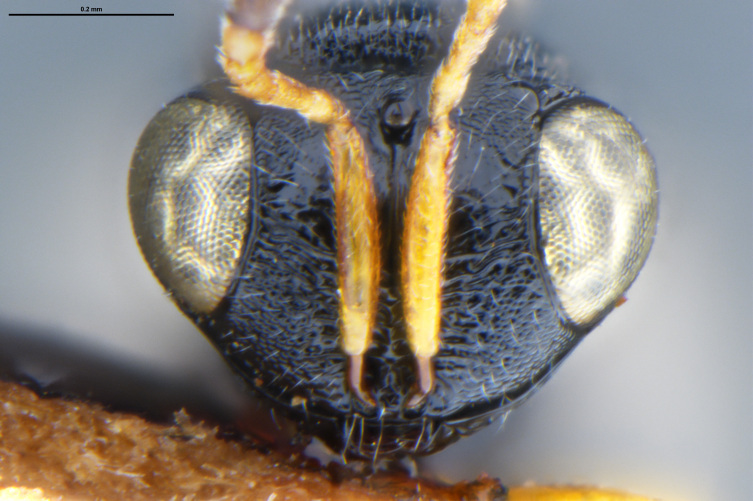
head, anterior view